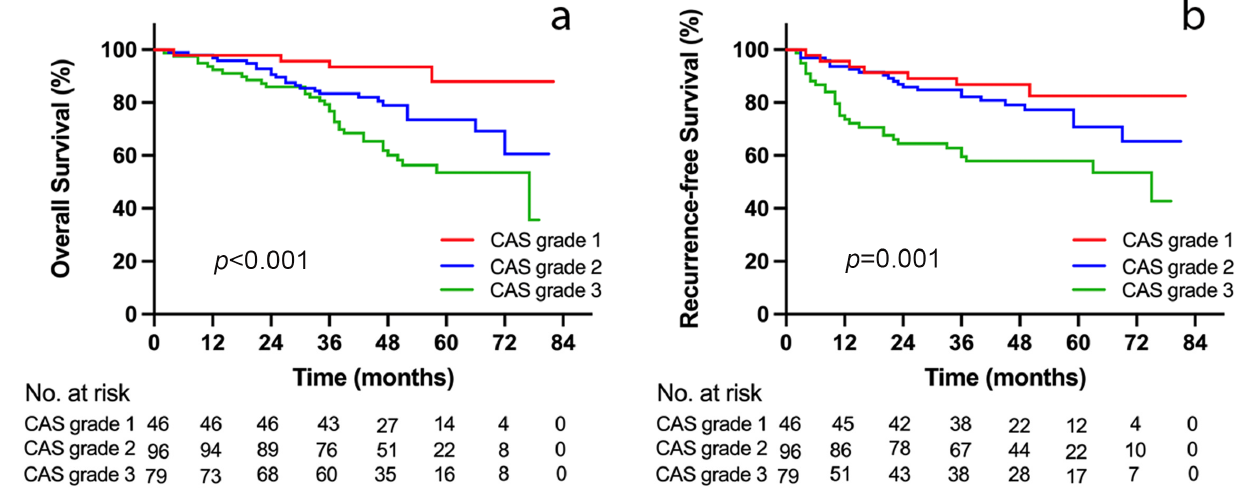
Figure 4. Kaplan–Meier curves for overall survival ( a ) and recurrence-free survival ( b ) stratified by CAS grade in the study cohort. CAS, combination of albumin–globulin score and skeletal muscle index.